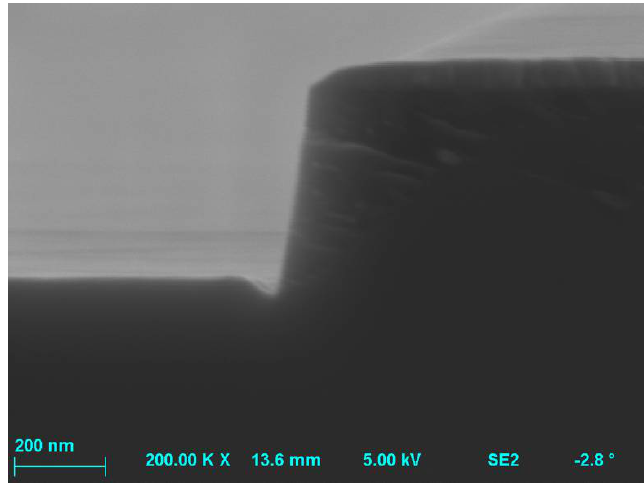
Figure 5. The SEM photo of the SiC/Cr MESA etched by SF 6 + O 2 plasma with a tip of the microtrench formation (at the bottom corner of the sidewall). The 65 nm-thick Cr layer is visible at the top of this MESA after the etching process with the following parameters: O 2 flow rate = 2 sccm, SF 6 flow rate = 20 sccm, P RIE = 100 W, P ICP = 1300 W, p = 10 mTorr, t = 10 min.